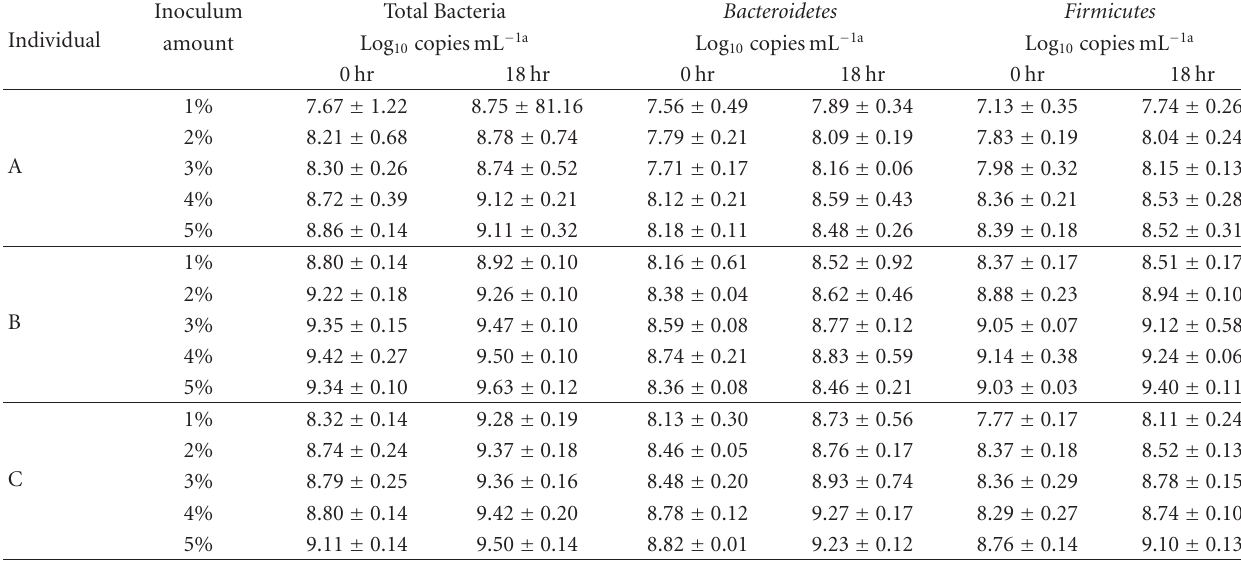
Data are expressed as the means and standard deviation from